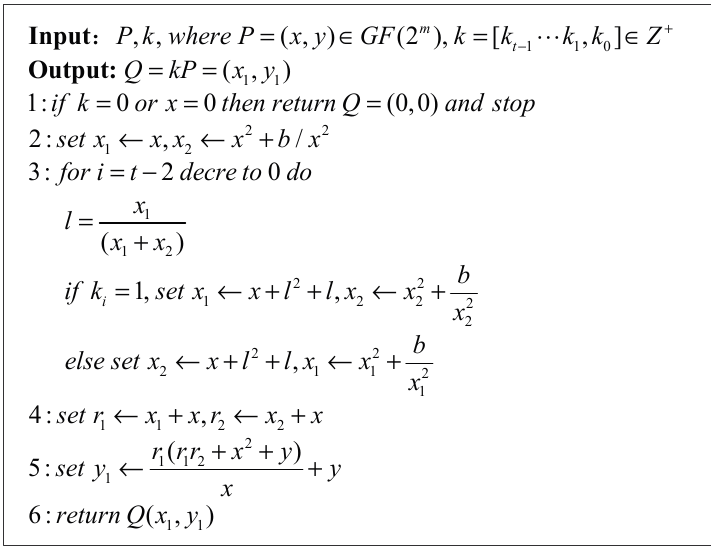
Algorithm 2. Montgomery Ladder Method in affine coordinates.